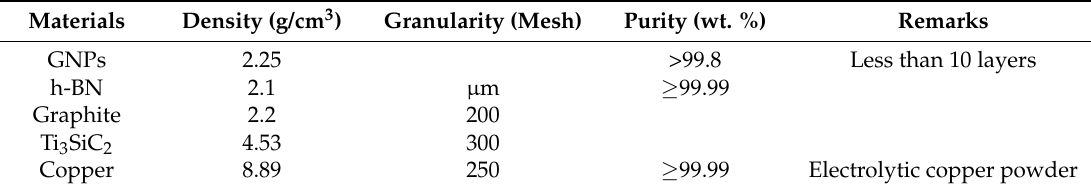
Table 1. Raw material powder